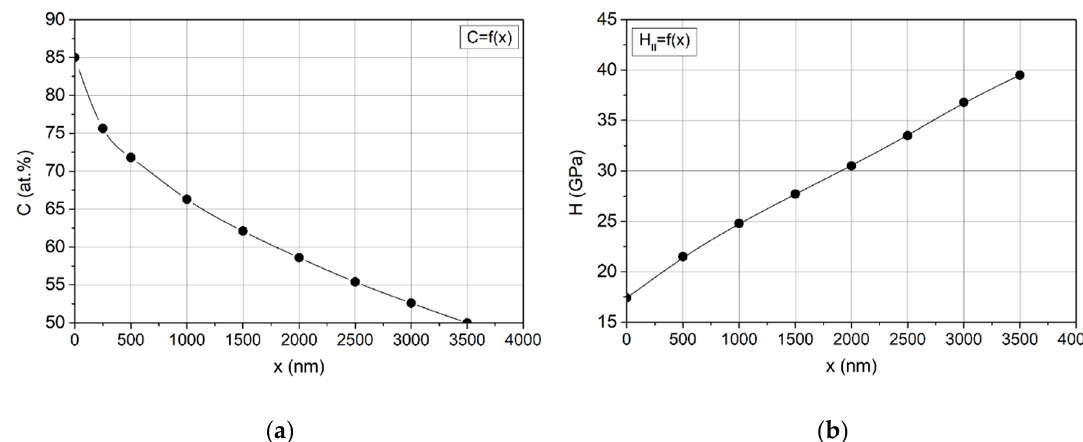
Figure 8. ( a ) Square root change in carbon content in the concentration range of 50–85 at.% determined using Formula (3) and ( b ) hardness change in coating determined based on carbon content profile accepted and changes in hardness calculated according to mixtures rule (Formula (2)).